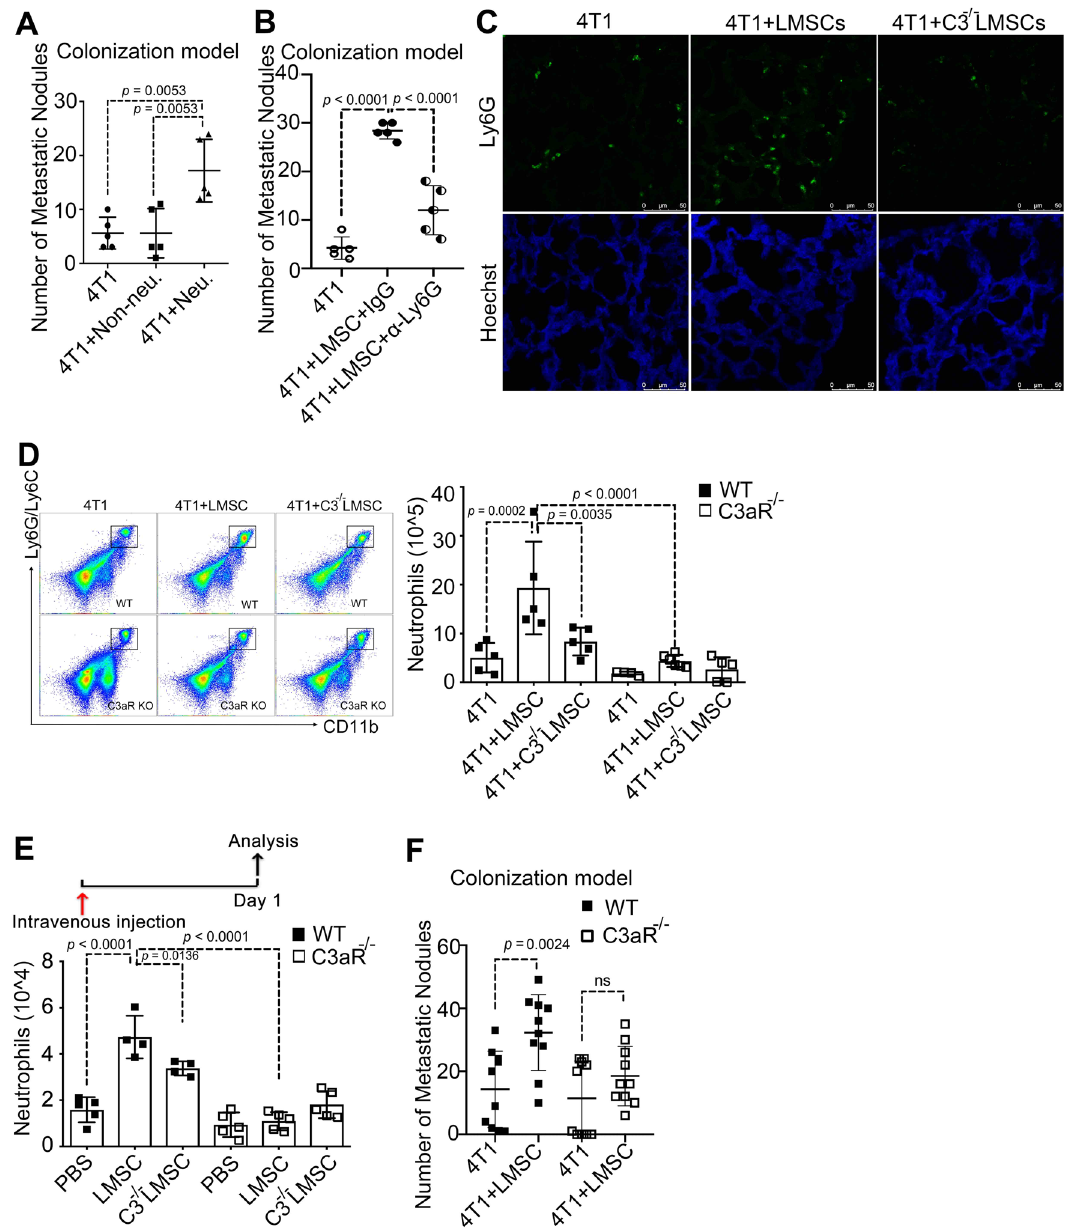
Fig. 3 Pro-metastatic neutrophil accumulation in the pre-metastatic niche is C3a receptor dependent. A Adoptively transferred neutrophils promoted 4T1 tumor metastasis. Neutrophils (2 × 10 6 ) and non-neutrophils (2 × 10 6 ) isolated from the bone marrow of BALB/c mice via magnetic beads sorting were respectively co-administered with 4T1 cells into BALB/c mice. LMNs were counted on day 14. n = 5 mice each. B Depletion of neutrophils completely abolished the metastasis-promoting activity of LMSCs. After co-administration of LMSCs with 4T1 cells into BALB/c mice, anti-Ly6G ( α -ly6G, 50 μ g per mouse) or IgG was administered intraperitoneally on days 2, 4, 6, 8, 10, and 12. LMNs were counted on day 14. n = 5 mice each. C Lack of C3 eliminated lung in fi ltration of neutrophils. WT-LMSCs and C3 − / − LMSCs were respectively co-injected with 4T1 cells into wild-type mice and the lung tissues were stained using anti-Ly6G. Scale bar represents 50 μ m. The images were representative of those generated from three mice each group. D C3aR expression on neutrophils was required for their accumulation in the lung. WT-LMSCs and C3 − / − LMSCs were respectively co-injected with 4T1 cells into wild-type or C3aR − / − mice, and the population of neutrophils were analyzed on day 14 by fl ow cytometry. n = 5, 5, 5, 4, 6, and 5 mice. E LMSCs recruited neutrophils via the C3 – C3aR axis. LMSCs or C3 − / − LMSCs injected into wild-type or C3aR − / − mice, respectively. The mice were killed for the examination of neutrophils in the lung 24 h after injection of LMSCs. n = 5, 4, 4, 5, 5, and 5 mice. F LMSCs failed to promote metastasis in C3aR-de fi cient mice. LMSCs were co-injected with 4T1 cells into wild-type or C3aR − / − mice and LMNs were counted on day 14. n = 10 mice each. All the data are presented as mean values ± SD. ns, not signi fi cant; p < 0.05, signi fi cant, using a one-way ANOVA with Sidak ’ s post test. Source data are provided as a Source Data fi le for Fig. 3A, B, D –